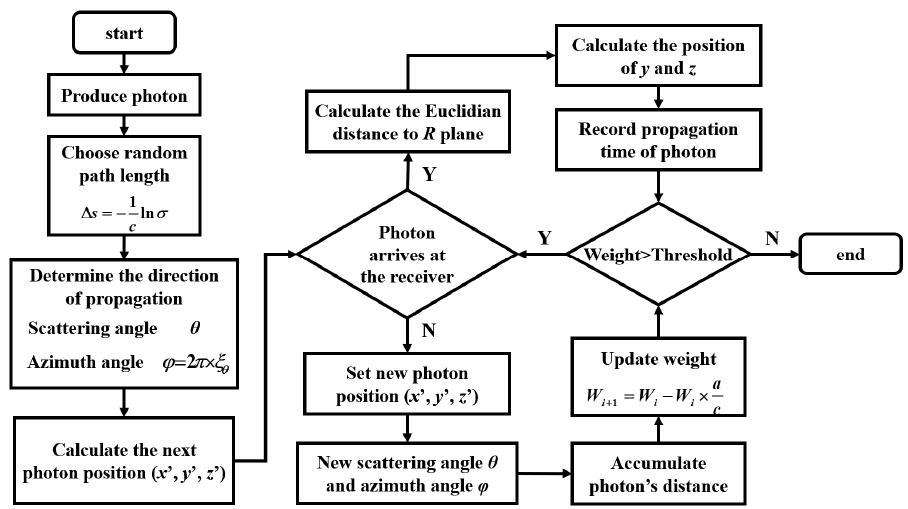
Figure 2. Flow chart for Monte Carlo